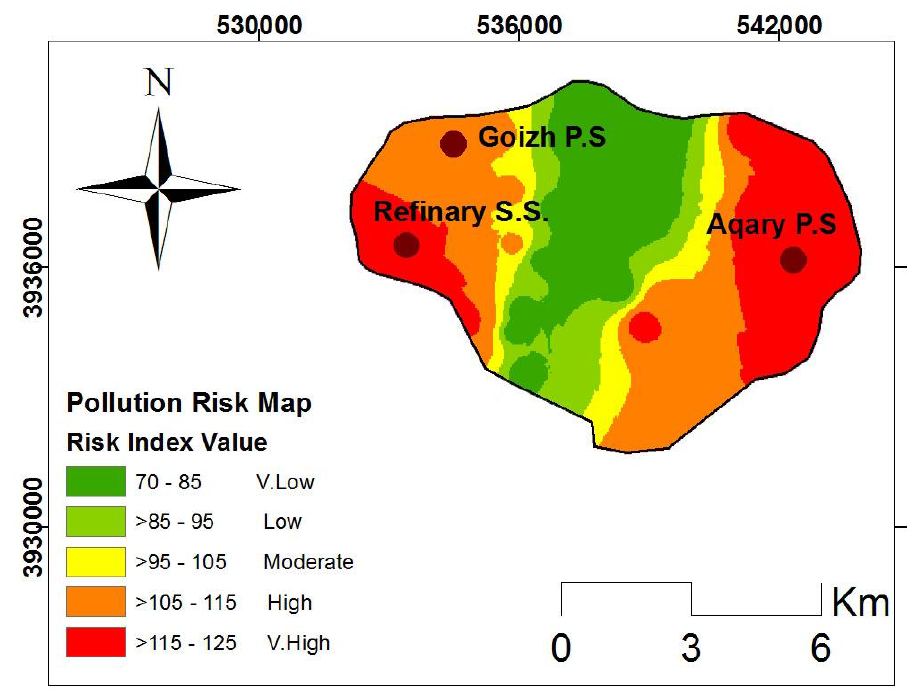
Figure 10. The final PRI map of the studied area.